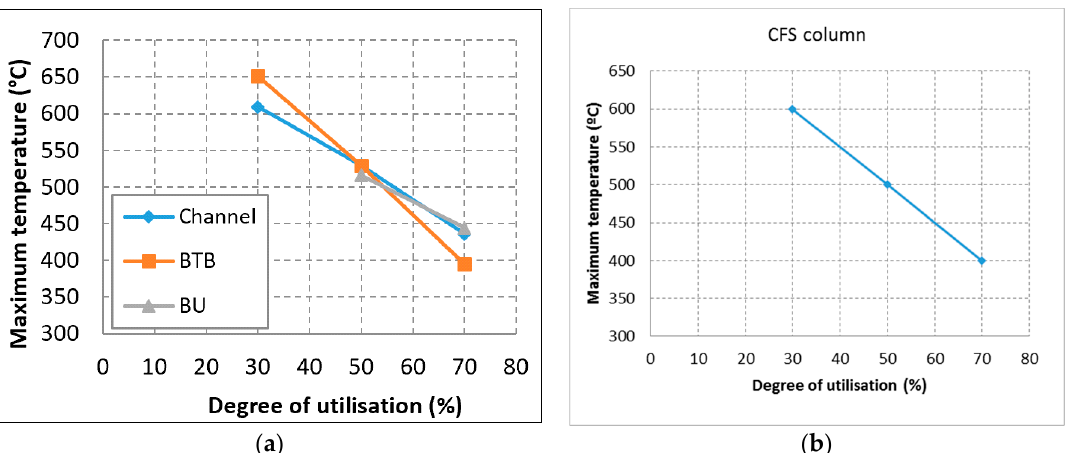
Figure 13. The graph of ( a ) Effect of column type on maximum temperature, ( b ) maximum temperature of a CFS column.